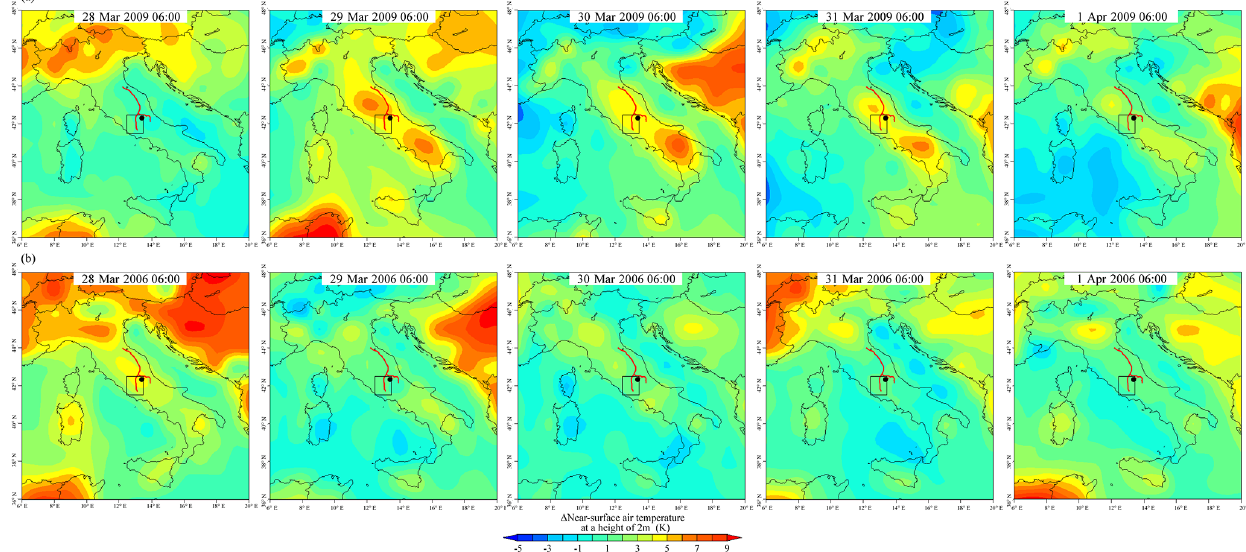
Figure 7. Spatial distribution of deviated near-surface air temperature at a height of 2m ( (cid:49) TMP2m) at 06:00UTC from 28 March to 1 April 2009 (a) and 2006 (b) , respectively. The black spot indicates the epicenter of the mainshock, the black rectangular box indicates the epicenter pixel, and the red line indicates the related main fault